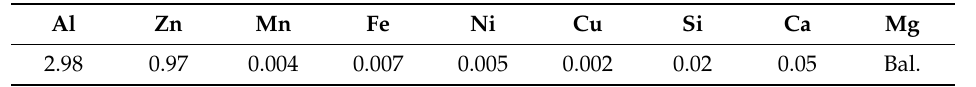
Table 4. Chemical composition of extruded AZ31 magnesium alloy (wt %).